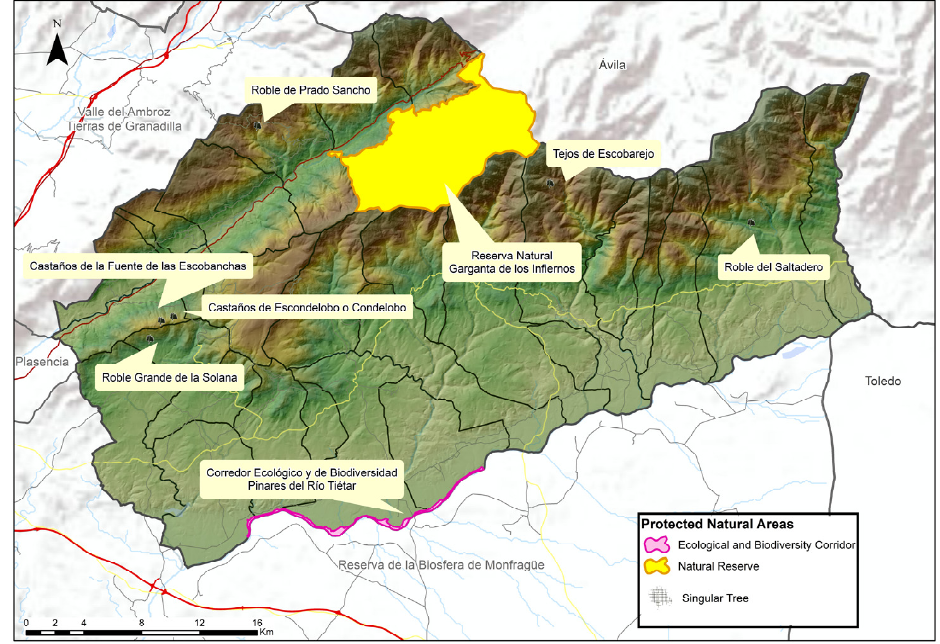
Figure 7. Map of the Network of Protected Natural Areas.